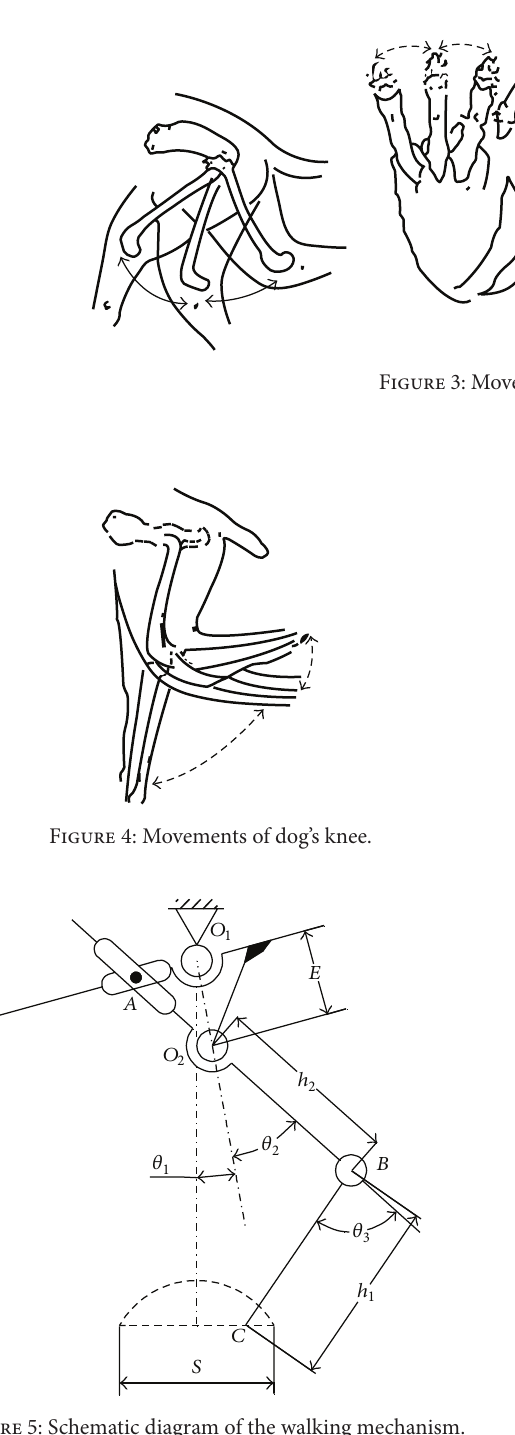
direction, then the intersection between calf 𝐵𝐶 and the flat dash line in Figure 5 also maintains steady horizontal velocity.